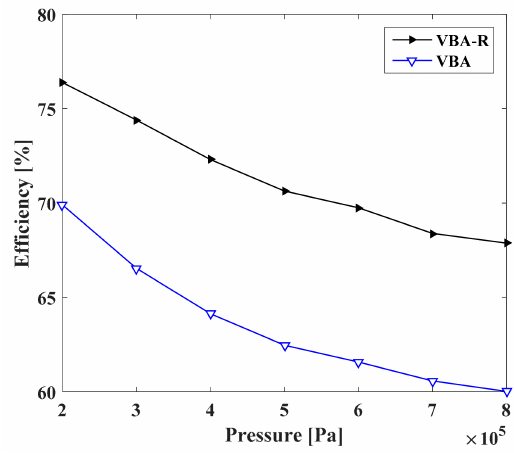
Figure 20. Comparison of VBA and